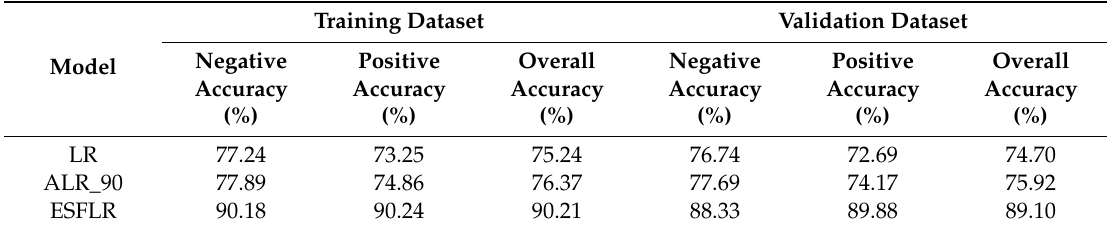
Table 10. The average results of 10-fold cross validation.